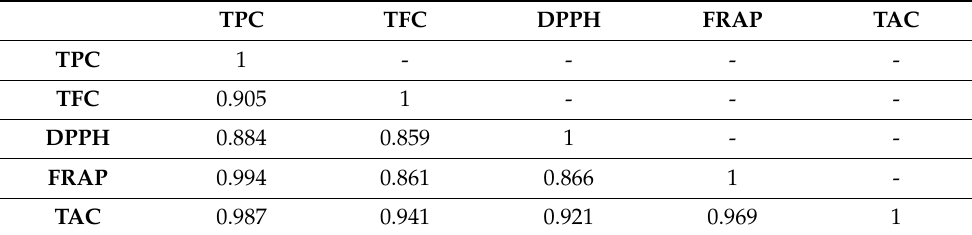
tent, TFC : total flavonoids content, DPPH : DPPH scavenging activity assay, FRAP : Ferric reducing between different parameters ( p < 0.05) are shown in the statistical data.